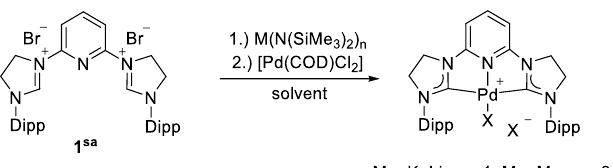
Table 1. Product selectivity using different solvents and transmetalating